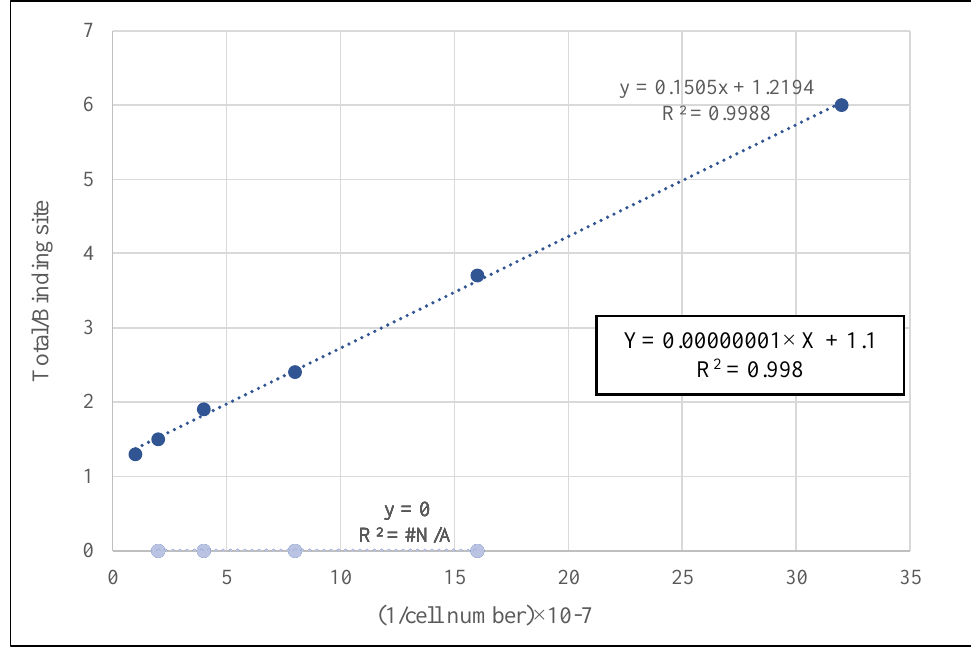
Figure 4. The immunoreactivity fraction shows the ability of the complex to bind to SW480 cells.